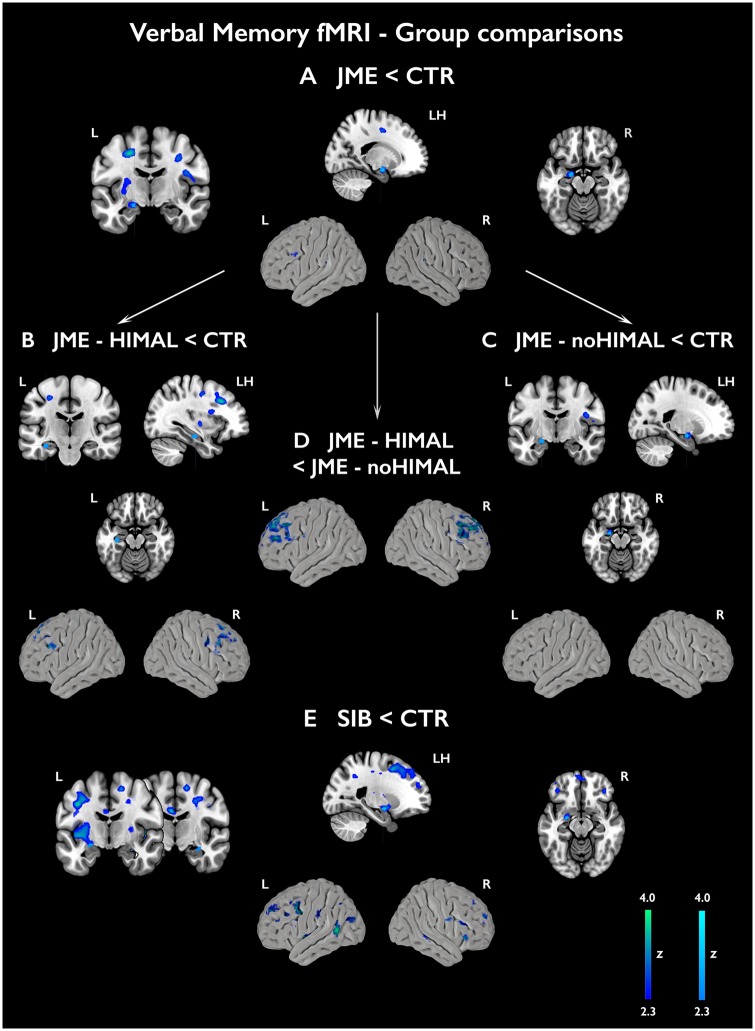

Group comparisons for subsequent verbal memory activations. The figure shows group comparisons for activation related to subsequently remembered verbal items (WR-WF) in patients with JME compared with controls (A), along with subgroup analyses for JME with HIMAL (B) and JME without HIMAL versus controls (C), and for the direct comparison of JME with and without HIMAL (D). Comparison of JME siblings against controls is shown in E. Statistical maps for mesiotemporal activations (cyan scale) show voxels included in the 12-mm diameter spherical regions of interest used for multiple comparison correction, where peak-level significance at P < 0.05-FWE corresponds to z-scores >2.3). Extra-mesiotemporal activations are displayed at an uncorrected threshold (P < 0.01, cluster extent threshold of 10 voxels; blue-green colour scale). ‘LH’ refers to a sagittal section of the left hemisphere. Colour bars reflect z-score scales for mesiotemporal (right) and extra-mesiotemporal activations (left). MNI coordinates are provided in Supplementary Table 3.